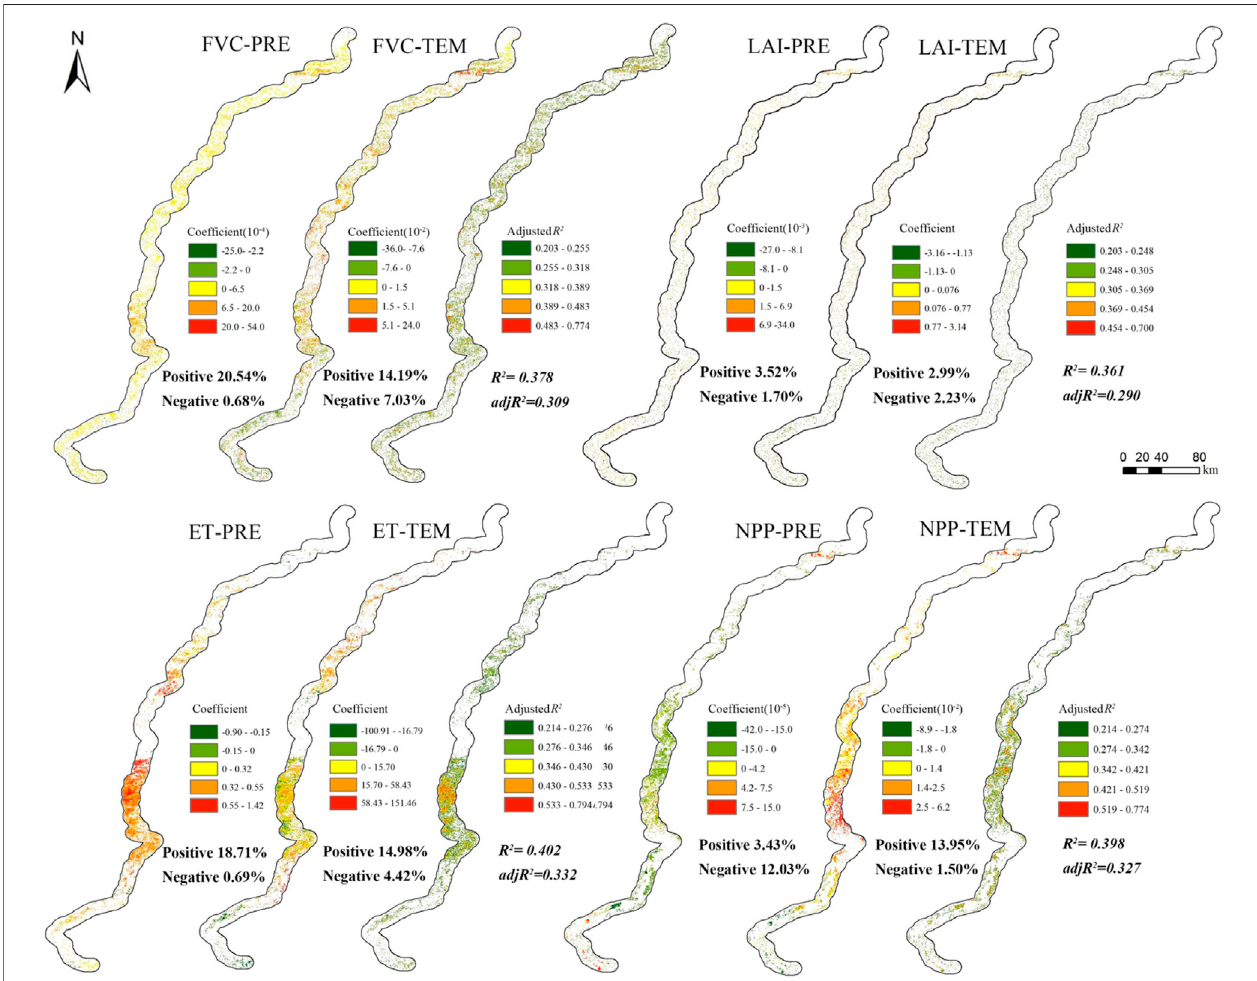
FIGURE 7 | Variation trends of ecosystem service indicators against climate